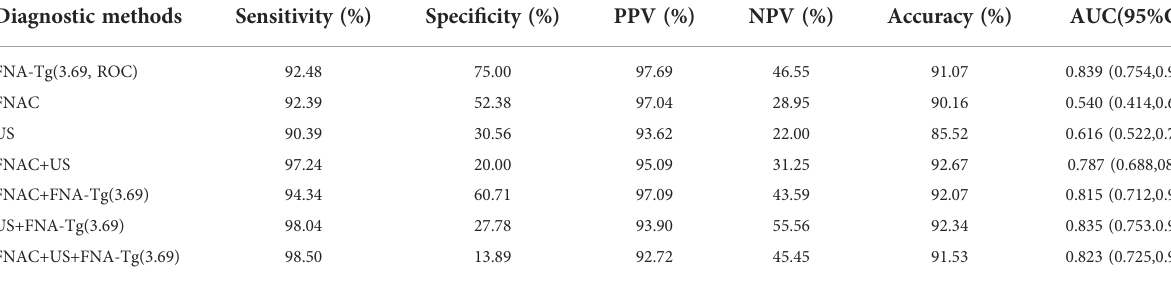
TABLE 4 Comparison of diagnostic value between US, FNAC and